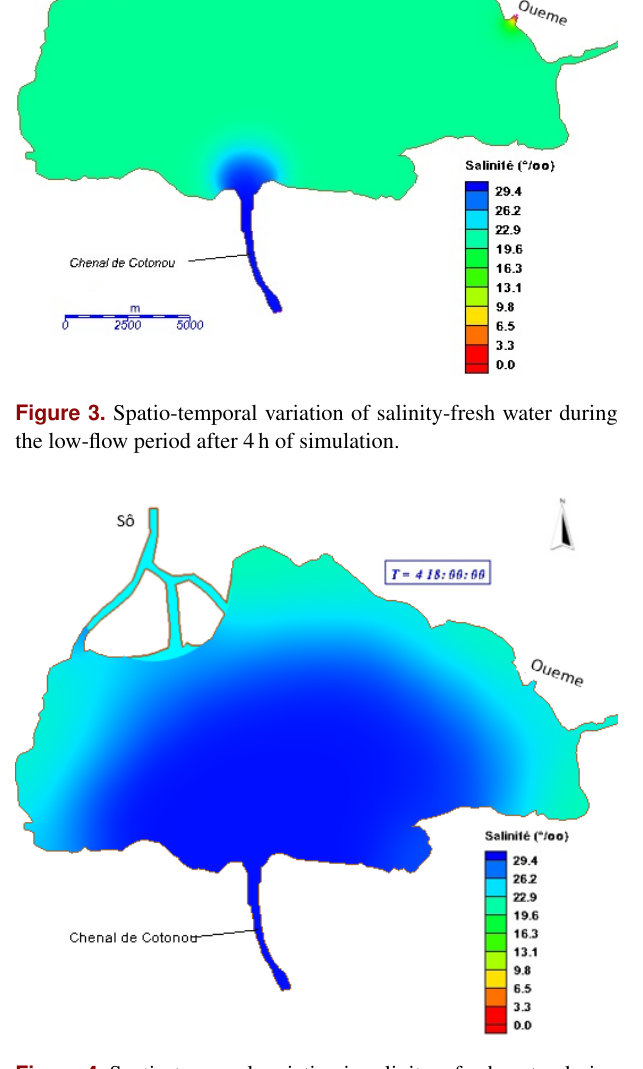
Figure 4. Spatio-temporal variation in salinity – fresh water during the low water period after 4d